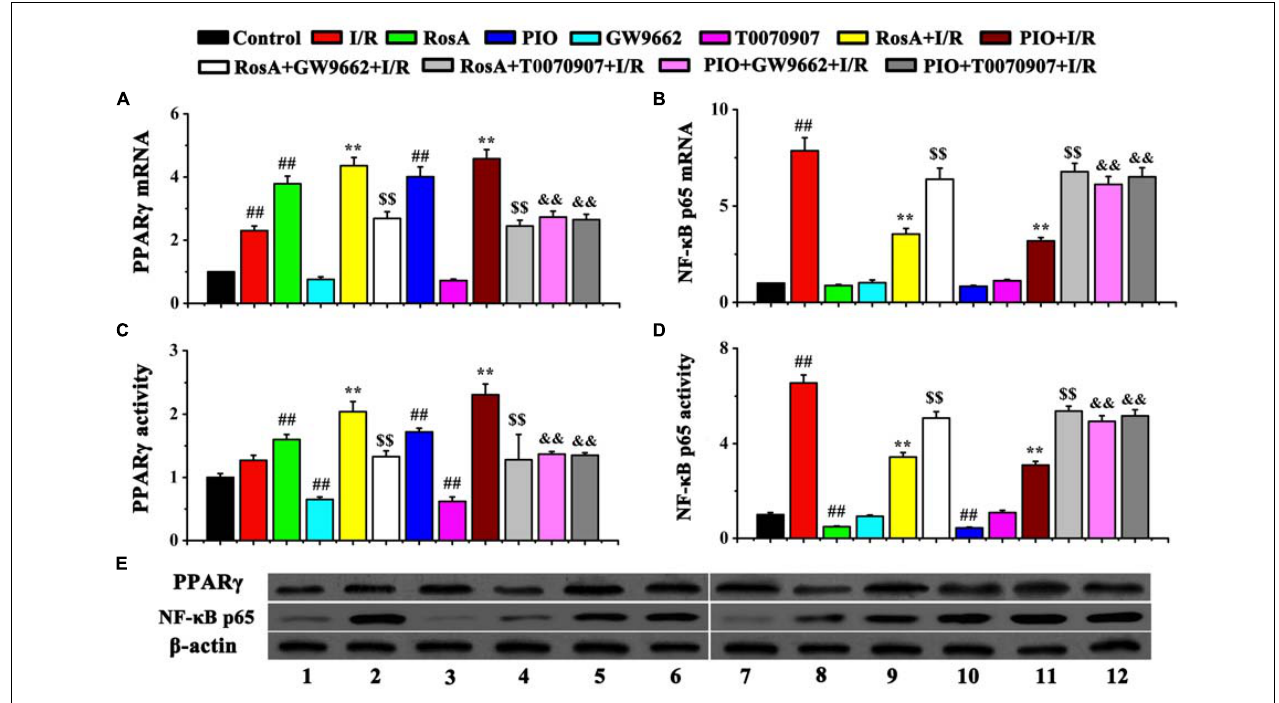
FIGURE 5 | The effect of RosA on the mRNA levels and protein levels of PPAR γ and NF- κ B p65 in rat cardiac tissue. (A) The effect of RosA on the mRNA levels of PPAR- γ ; (B) The effect of RosA on the mRNA levels of NF- κ B p65; (C) Quantitative analysis of PPAR γ protein levels; (D) Quantitative analysis of NF- κ B p65 protein levels. (E) Measurement of PPAR γ and NF- κ B p65 protein levels in rat hearts by Western blot. (1) Control group; (2) I/R group; (3) RosA group; (4) GW9662 group; (5) RosA+I/R group; (6) RosA+GW9662+I/R group; (7) PIO group; (8) T0070907 group; (9) PIO+I/R group; (10) RosA+T0070907+I/R group; (11) PIO+GW9662+I/R